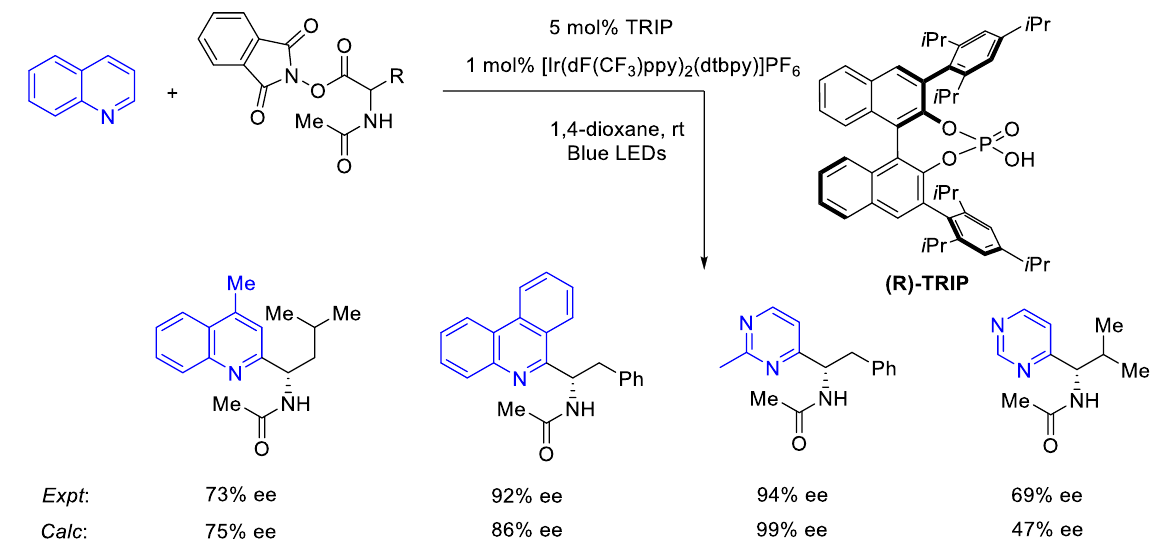
Figure 23. Enantioselective chiral CPA catalyzed Minisci reaction [185]. All values are from the work of Goodman and co-workers [31]. % ee are calculated from ∆∆ G ‡ 298.15 K, 1 atm at SMD(1,4-dioxane)/M06-2X/def2-TZVPD//B3LYP/6-31G(d,p) from the cited reference.